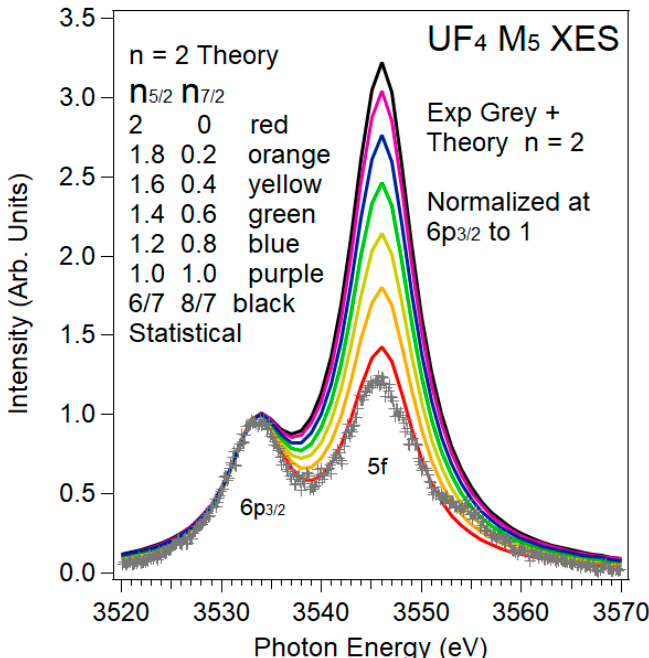
Figure 7. Shown here is the experimental M 5 XES spectrum of UF 4 and the simulated spectra for n = 2 and various values of n 5/2 . The simulation used normalized Lorentzian line shapes, with a half-width at half-max of Γ . For the 6p 3/2 , Γ = 3.5 eV. For the 5f peak, Γ = 4 eV.